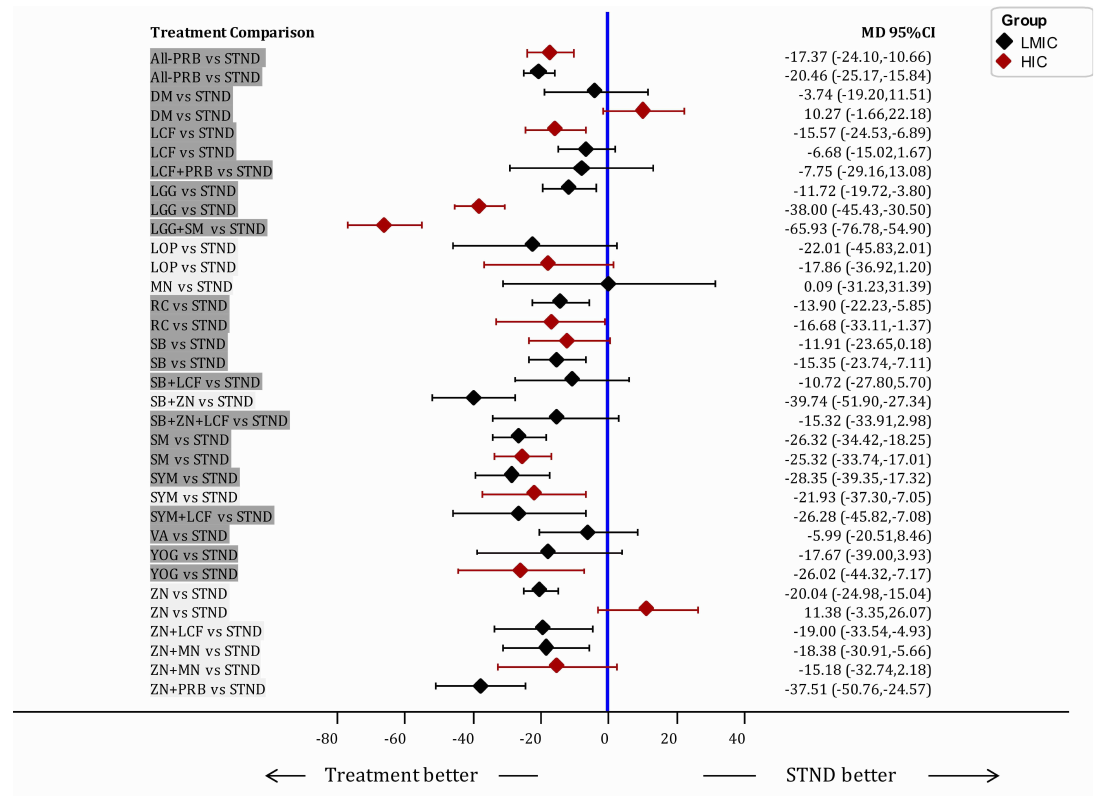
Fig 4. Forest plot of subgroup analyses by country income classification. All interventions are compared to STND. Subgroup analyses were performed based on the country income classification (based on the World Bank classification at 2016) Comparisons are highlighted in Dark Grey if the GRADE Quality was Low or Very Low, and in Light grey, when Quality was High or Moderate. When an intervention has no effect estimate in HIC means that there were no studies in HIC for the mentioned interventions. MD: Mean difference; 95CrI%: 95% Credible Intervals; LMIC: Low- and Middle-Income countries; HIC: High-income countries. Interventions’ abbreviations are described in Table 1.